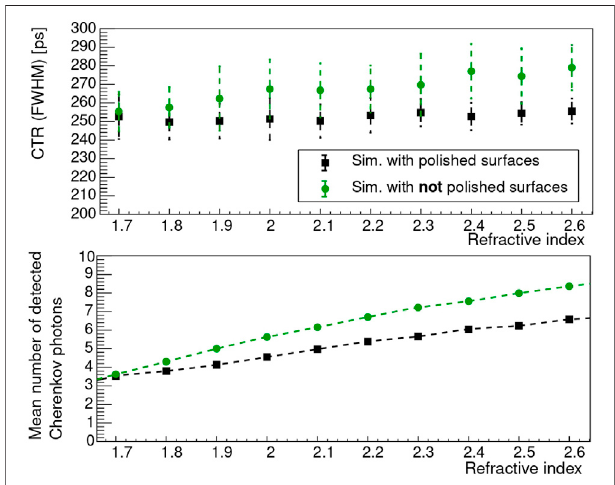
FIGURE 8 | Simulation results on the mean number of detected Cherenkov photons and CTR as a function of the refractive index.